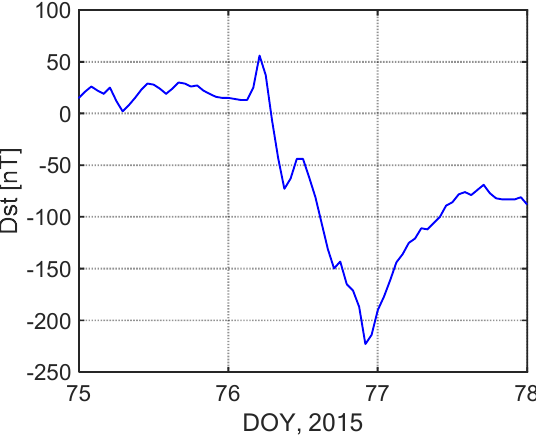
Figure 16. Time series of disturbance storm time (Dst) index on days of year (DOYs) 075–077 in 2015.